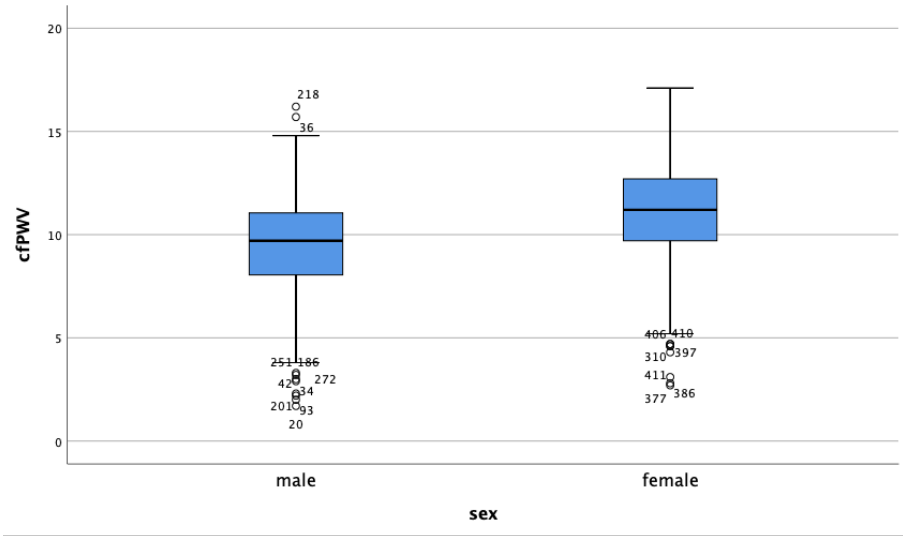
Figure 1. cfPWV according to sex.